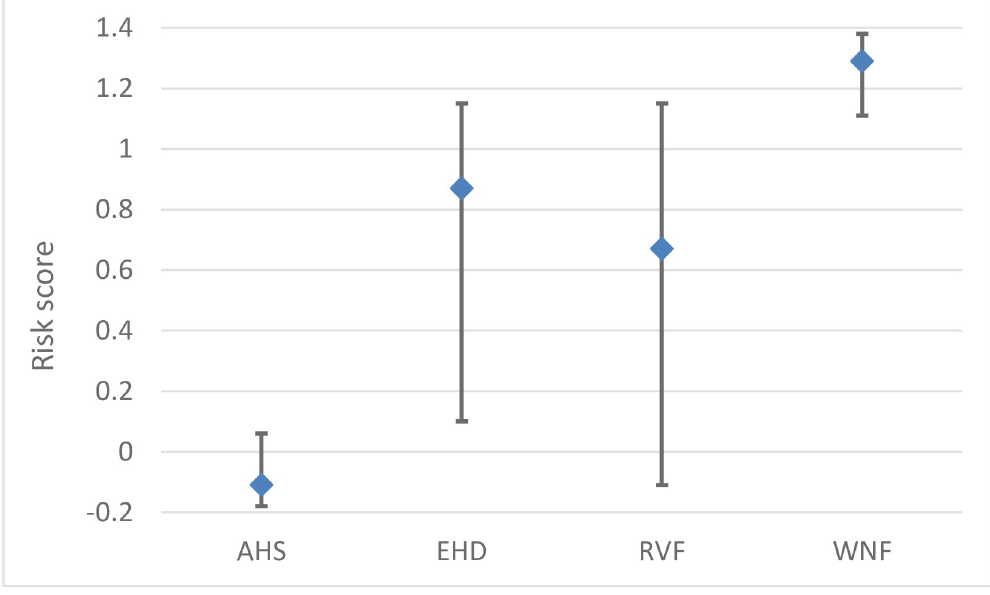
Fig 4. Risk scores (median values) and their uncertainty (95% uncertainty interval) for the estimated epidemic size of four vector-borne diseases for the Netherlands. AHS = African horse sickness; EHD = epizootic haemorrhagic disease; RVF = Rift Valley fever; WNF = West Nile